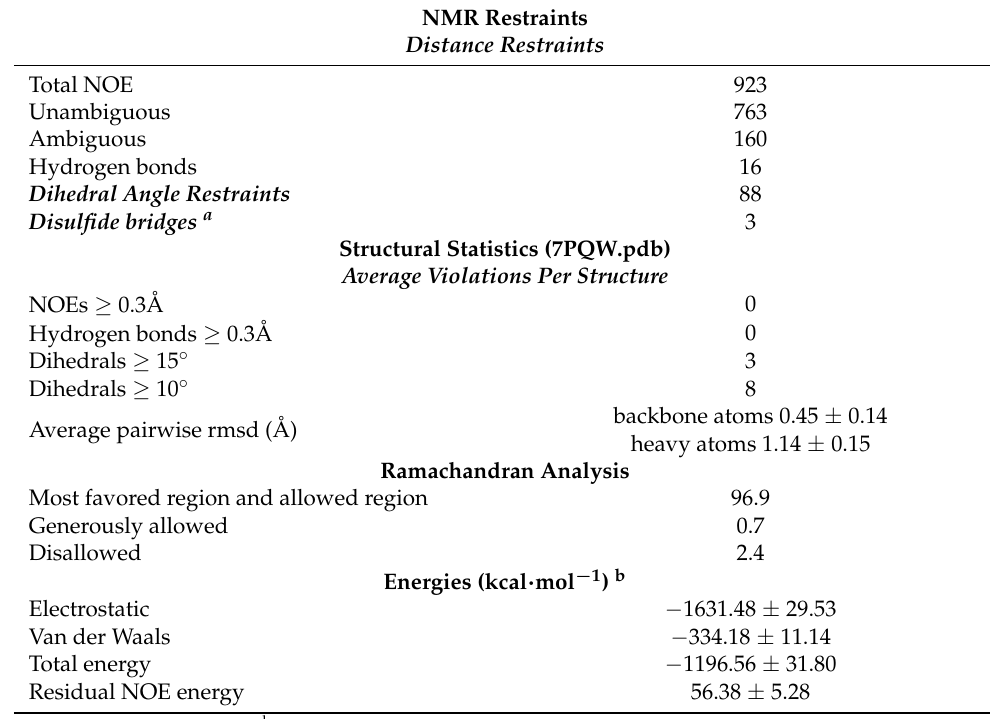
Table 4. NMR constraints and structural